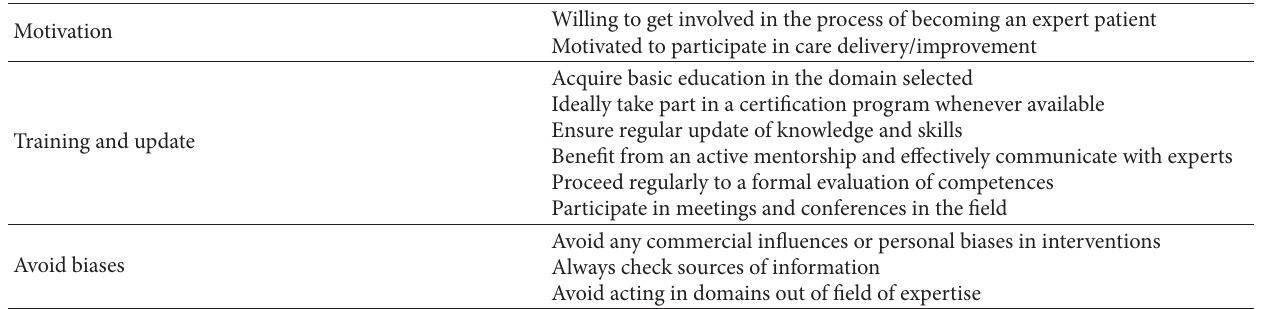
Table 2: Requirements to become (and remain) an expert